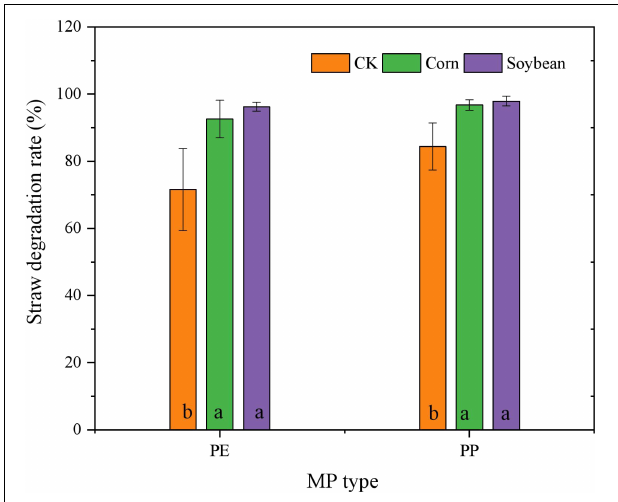
FIGURE 8 | Mass content (%) of straw degraded in the treatments of crop growth (soybean and maize, different types of MP). Columns followed by the same letter were not significantly different based on a least significant difference (LSD) multiple range test ( p < 0.05).